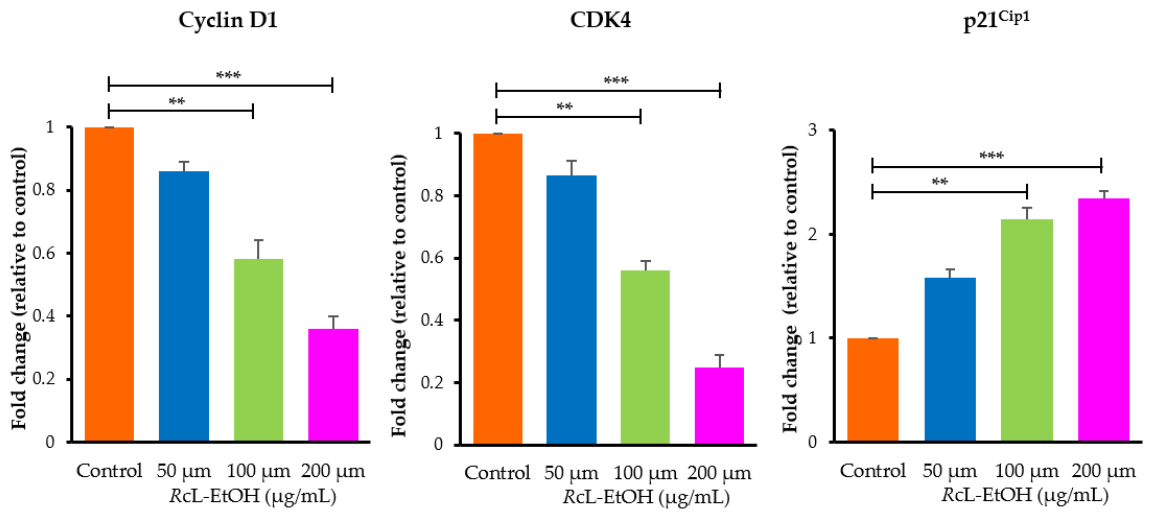
Figure 7. Changes within the mRNA expression of genes involved in cell cycle progression (cyclin D1, CDK4 and p21 cip1 ) after exposure to R cL-EtOH. ** p < 0.01 and *** p < 0.001 vs. control.